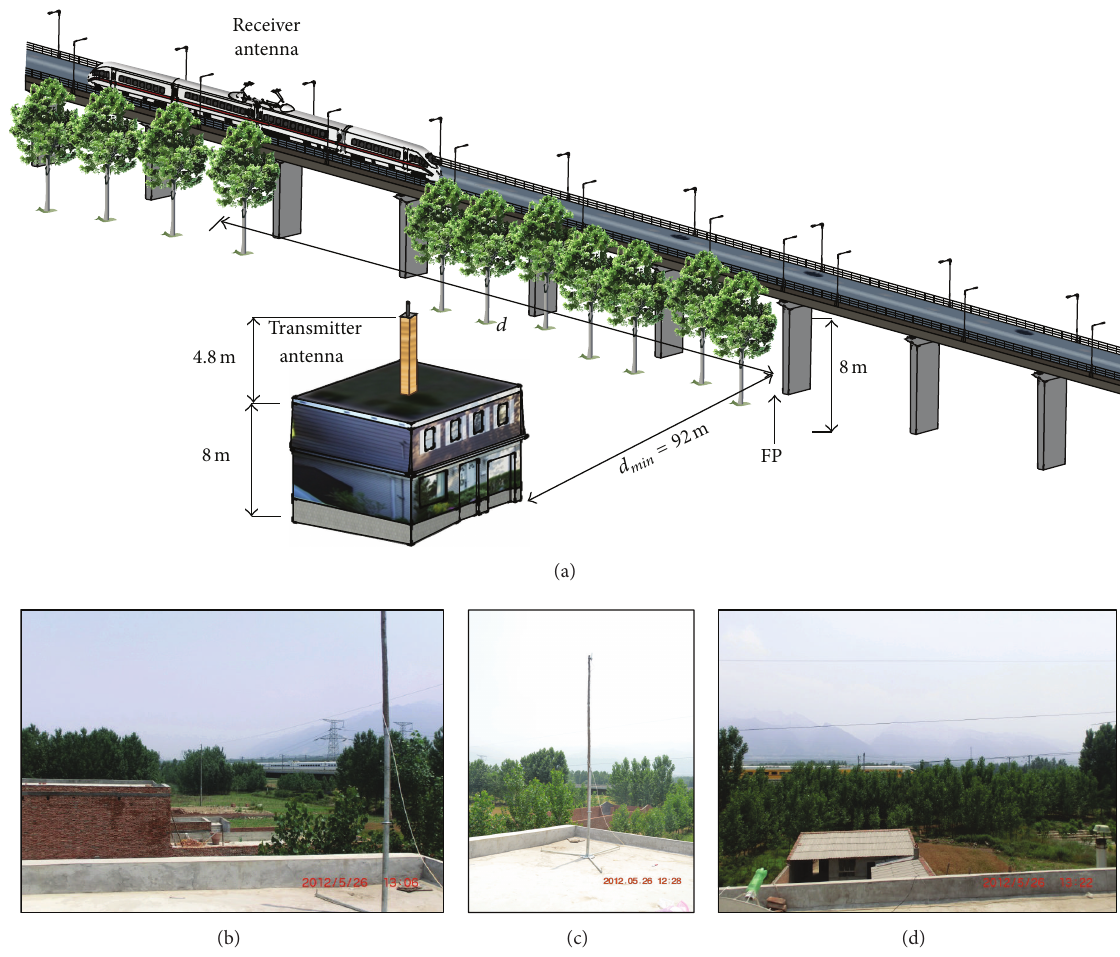
Figure 1: Propagation environment: (a) measurement scenario, (b) and (d) photos of the propagation region remote and close to the transmitter, and (c) transmitter antenna.